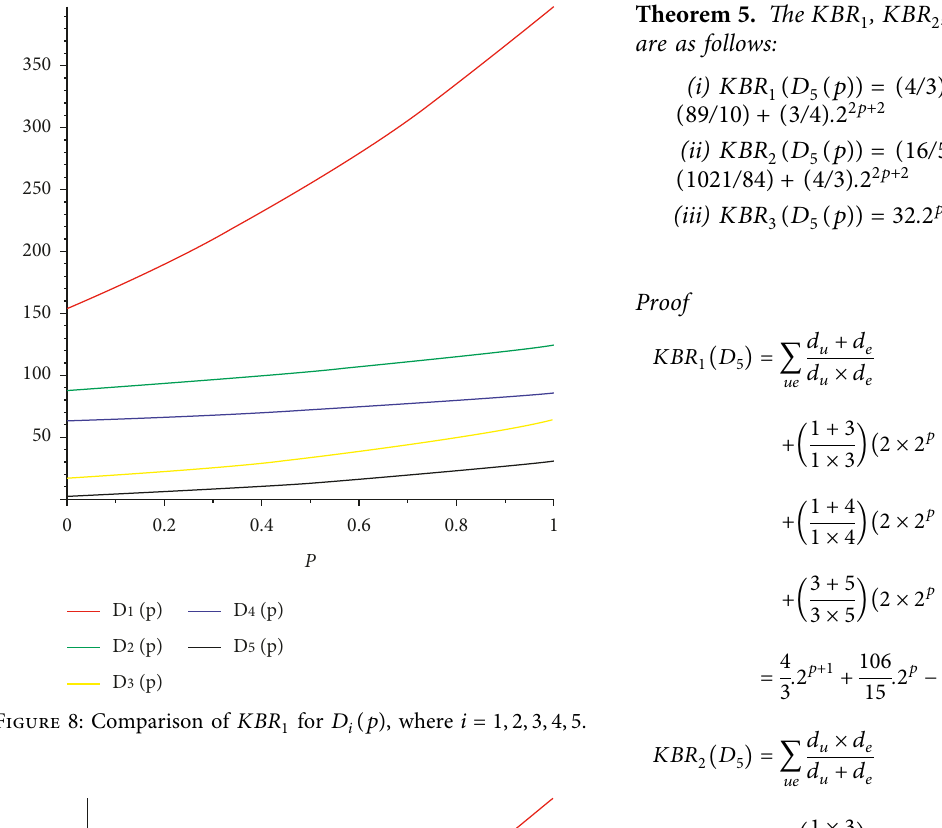
for D i ( p ) , where i � 1 , 2 , 3 , 4 , 5. 1